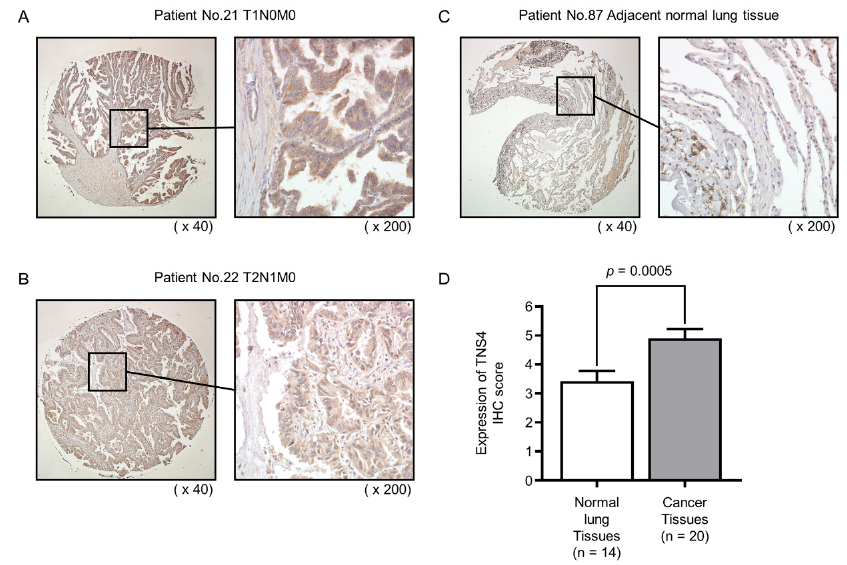
Figure 5. Immunohistochemical staining of TNS4 protein in clinical LUAD specimens. ( A , B ) The overexpression of TNS4 was observed in the cytoplasm of cancer cells. ( C ) TNS4 was weakly stained or not detected in normal lung specimens. ( D ) Comparison of immunohistochemical staining of TNS4 in LUAD specimens and normal lung specimens. LUAD specimens showed higher expression of TNS4 than normal lung